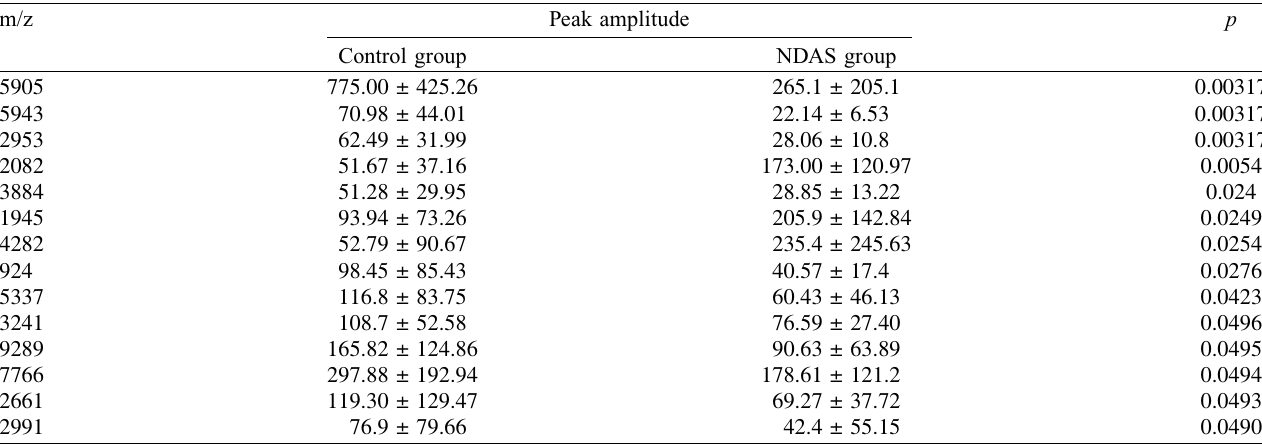
Table 2. Fourteen differential peaks were detected in sera from newly developed advanced schistosomiasis (NDAS) cases when compared to sera from healthy controls using MALDI-TOF-MS and ClinProTools analysis.